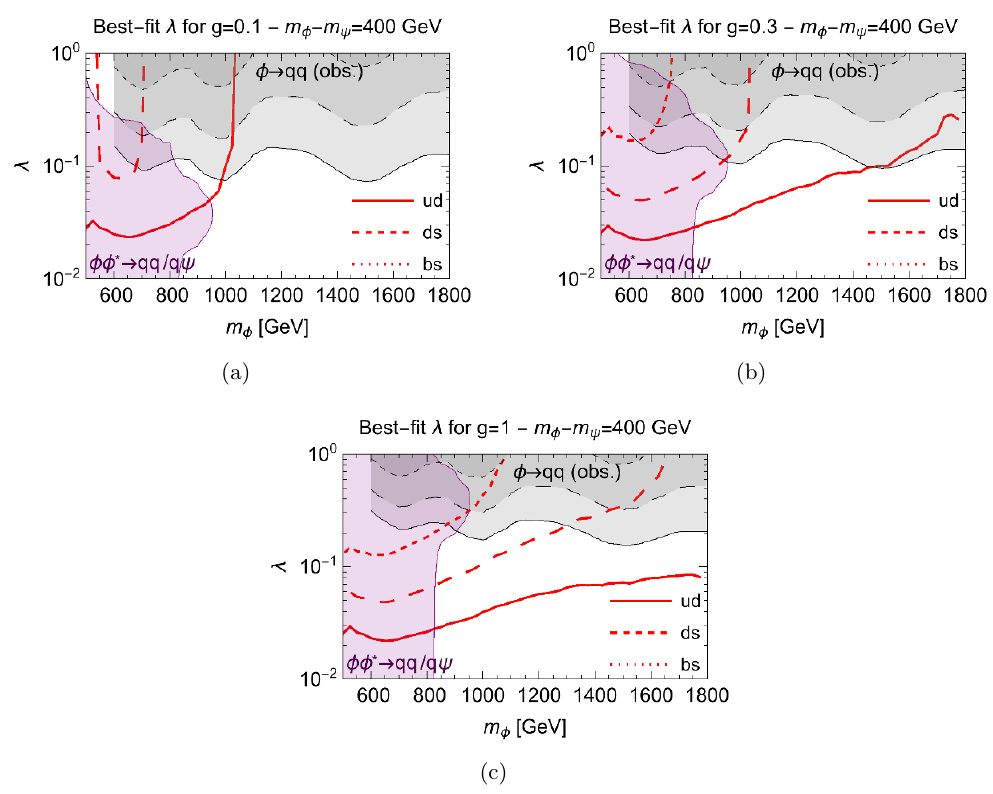
Figure 9 . Best-(cid:12)t values and constraints for the full model in eq. (3.3). In the di(cid:11)erent plots, we set g = 0 : 1 ; 0 : 3 and 1 respectively, while each plot shows in red the value of (cid:21) needed to reproduce the best-(cid:12)t cross section as a function of the (cid:30) mass, having (cid:12)xed m (cid:30) (cid:0) m = 400 GeV, for di(cid:11)erent partons in the initial state: ud (solid), ds (dashed) and bs (dotted). The same line styles are used to denote regions excluded by dijet resonance searches [16] (which depend on the initial state), while the purple shaded area shows limits set by CMS033 [13] on pair-produced (cid:30) ’s with mixed